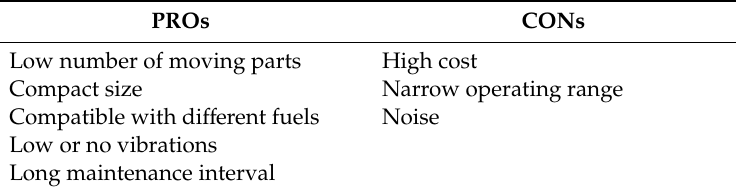
Figure 3. Micro GT. Table 6. PROs and CONs of a micro-gas